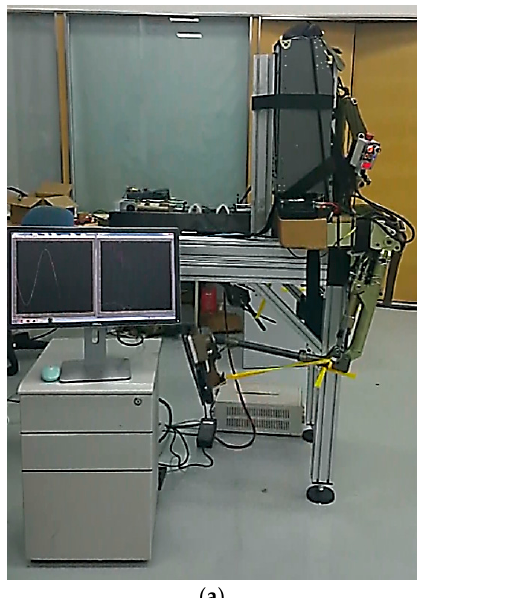
Table 2. Mean of tracking accuracy and response time of APAL.